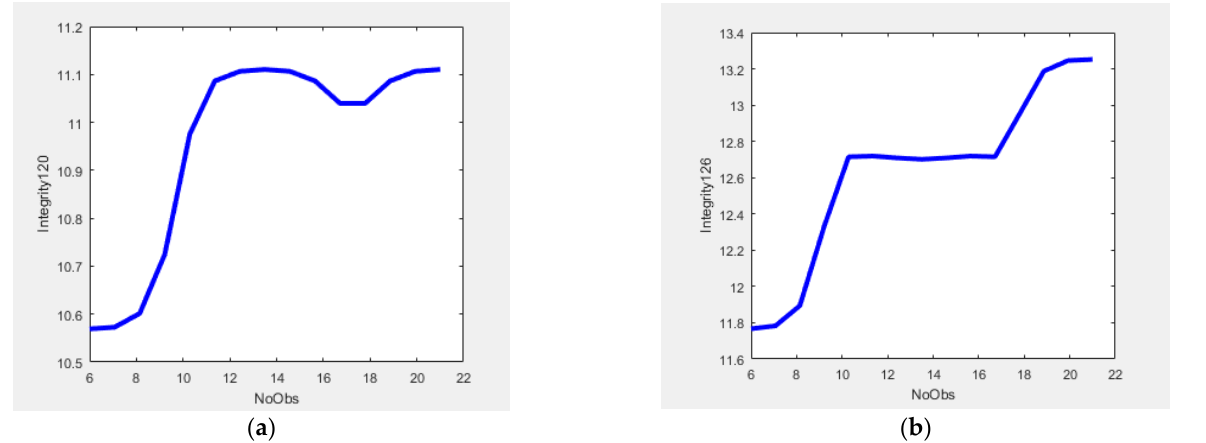
Figure 5. The correlation of the number of SSN observations ( x 3 ) and the integrity of PRN120 ( a ) and PRN126 ( b ) (Own study in MATLAB Fuzzy Logic Toolbox).